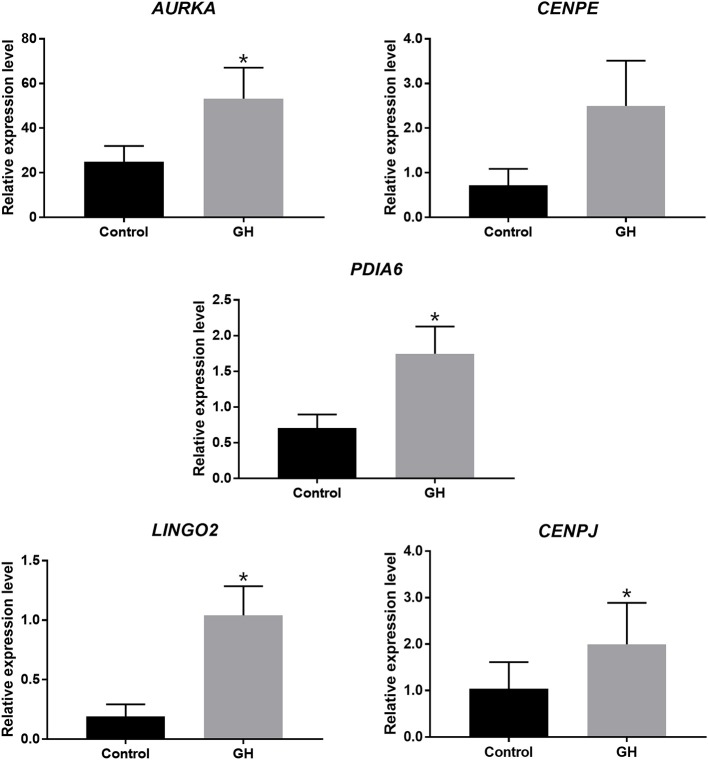
Real-time PCR for validation. *P < 0.05.